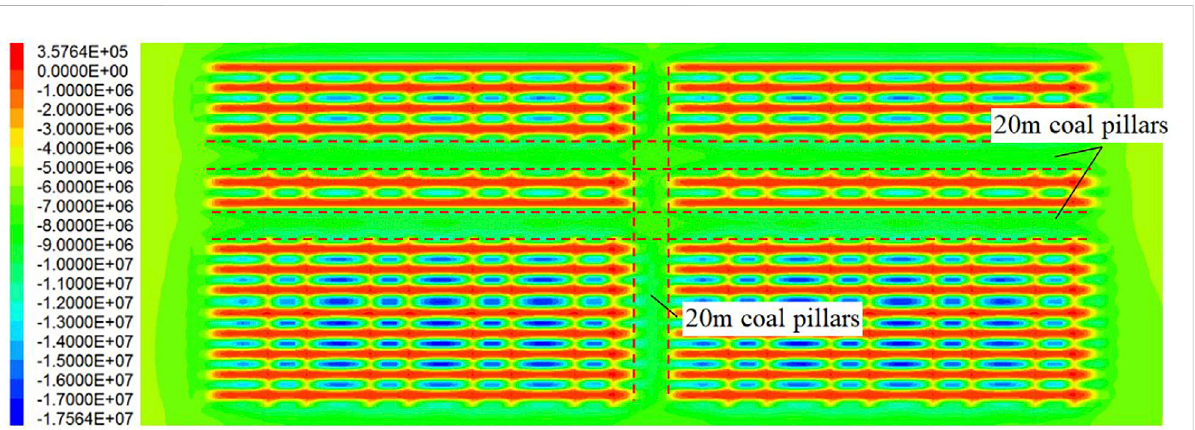
FIGURE 10 Vertical stress distribution of strata at 6m on top of 3# coal seam